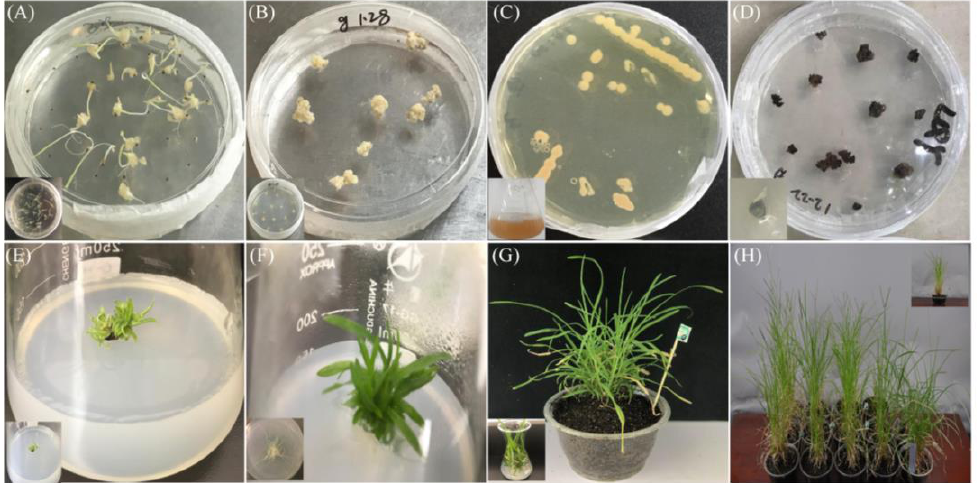
Figure 4. Agrobacterium -mediated genetic transformation of the EiKCS gene in goosegrass. ( A ) Callus induction with MZ04 seeds. ( B ) Callus subcultures. ( C ) Preparation and preservation of A. tumefaciens cells with the pCUbi1309:: EiKCS vector. ( D ) Infection, co-cultivation and screening of calli. ( E ) Differentiation of transformants. ( F ) Root induction of transformants. ( G ) Acclimatization and field transfer of transgenic plants. ( H ) Propagation of transgenic goosegrass plants.